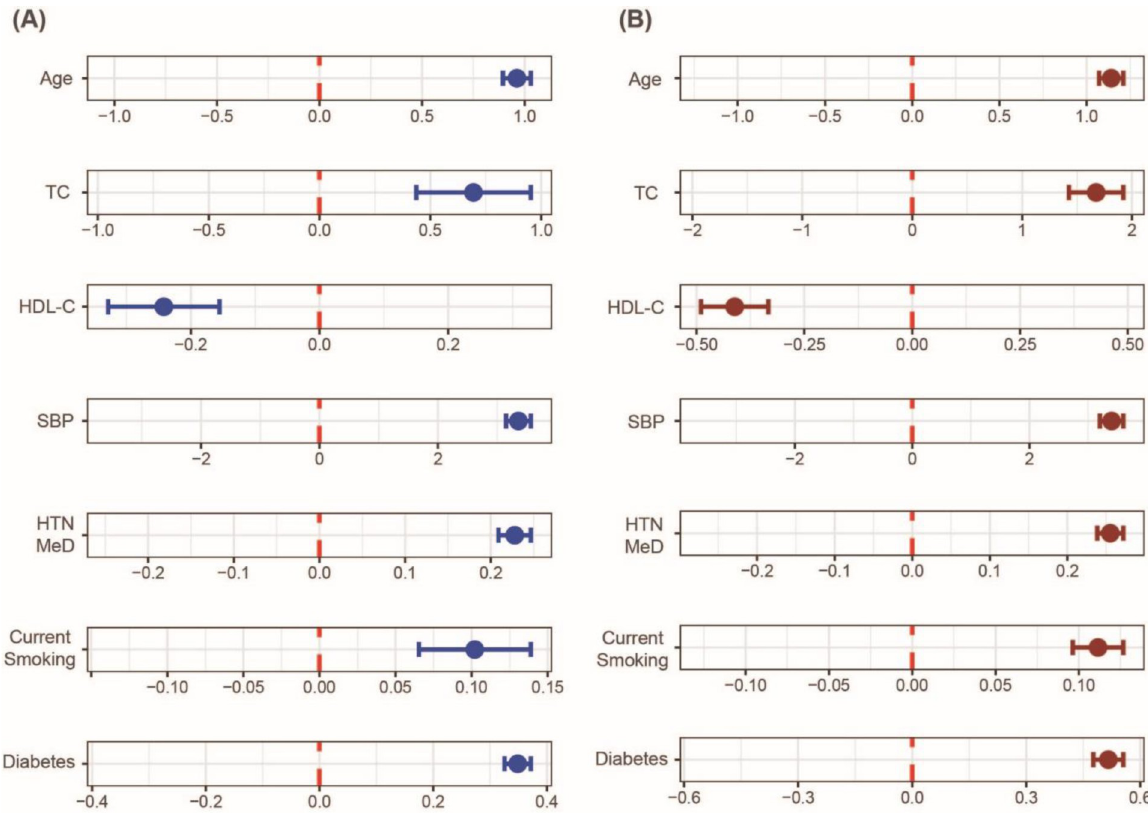
Fig 3. Relationship between albuminuria and cardiometabolic risk factors in Korean women (A) and men (B). Top four graphs (i.e., age, TC, HDL-C, SBP) were obtained by multivariate linear regression after setting the four predictors arranged separately as dependent variables. UACR was determined as the independent variable, and other remnant six predictors as covariates. The lower three graphs (i.e., AHM, smoking, diabetes) were obtained by multivariate logistic regression set to the same conditions as the multivariate linear regression. All x-axes indicate beta-coefficients obtained from the multivariate linear or logistic regressions. UACR levels were log-transformed for the associational analyses. Abbreviations: TC, total cholesterol; HDL-C, high-density lipoprotein cholesterol; SBP, systolic blood pressure; HTN Med, hypertension medication; DM, diabetes mellitus.